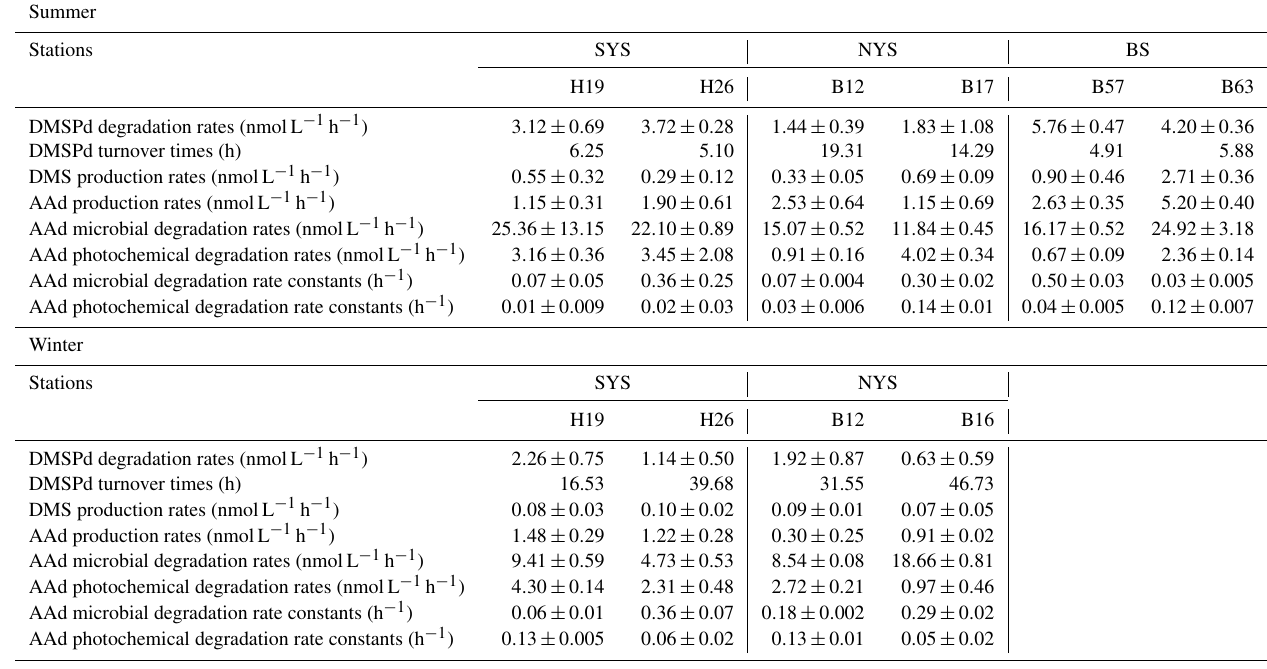
Table 4. Rates and rate constants of DMS and AAd production from DMSPd degradation and AAd degradation in the BS and YS during summer and